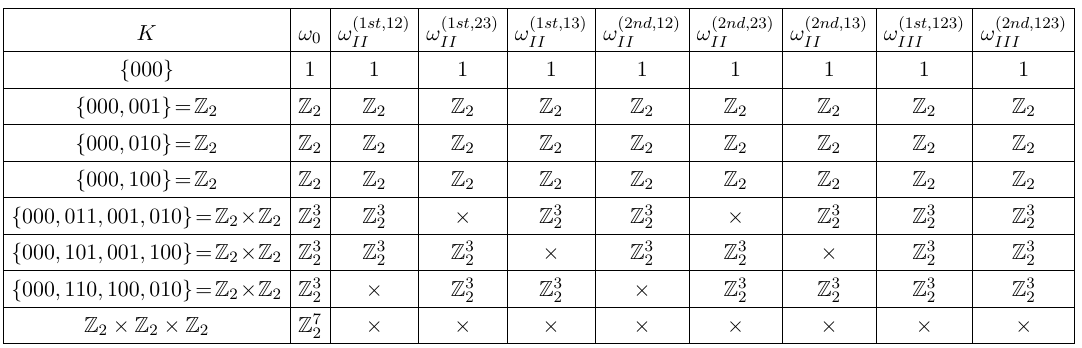
Table 1. 3-cochain solutions to the generalized Frobenius condition for G = Z 2 × Z 2 × Z 2 . A big × indicates “no